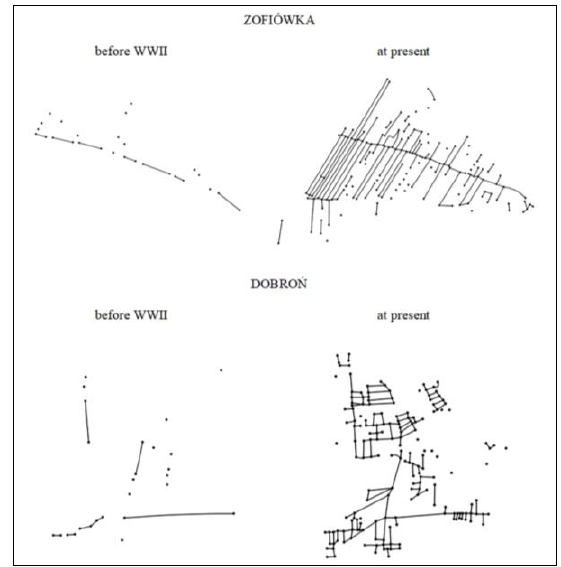
Fig. 7. Graphs depicting the average rank of morphological changes of the villages Zofiówka and Dobroń (in the extra- urban area) (Source: own